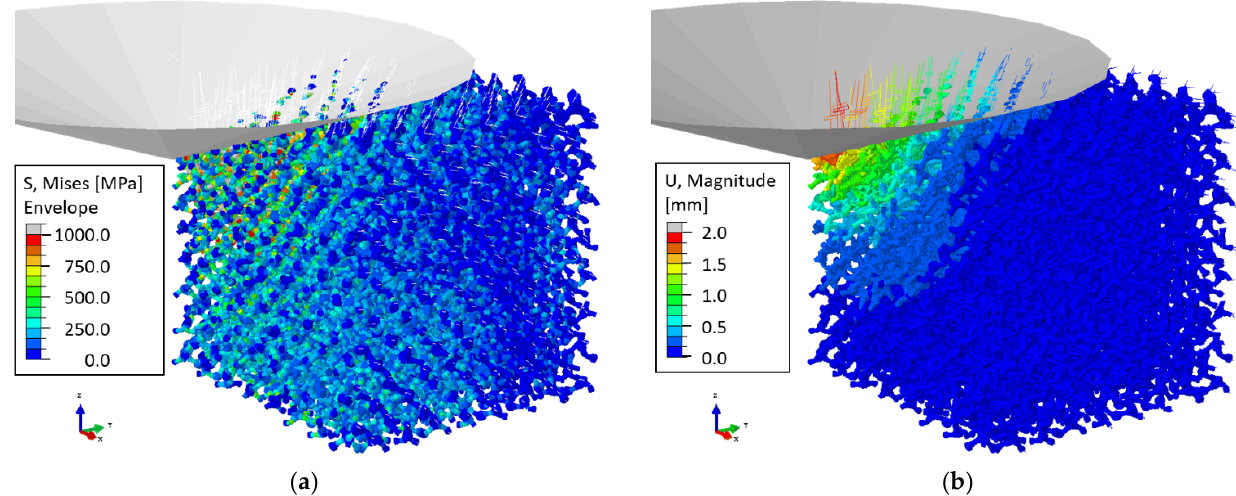
Figure 3. Nanoindentation model with a conical indenter displaced by 2 unit cells at a speed of 20 mm/s. Dashpots are attached at FE nodes located at free boundaries to stabilize oscillations in the dynamic simulation. Images show the deformation of the RVE at the end of the loading phase, where the color corresponds to ( a ) von Mises stress, and ( b ) displacement magnitude.